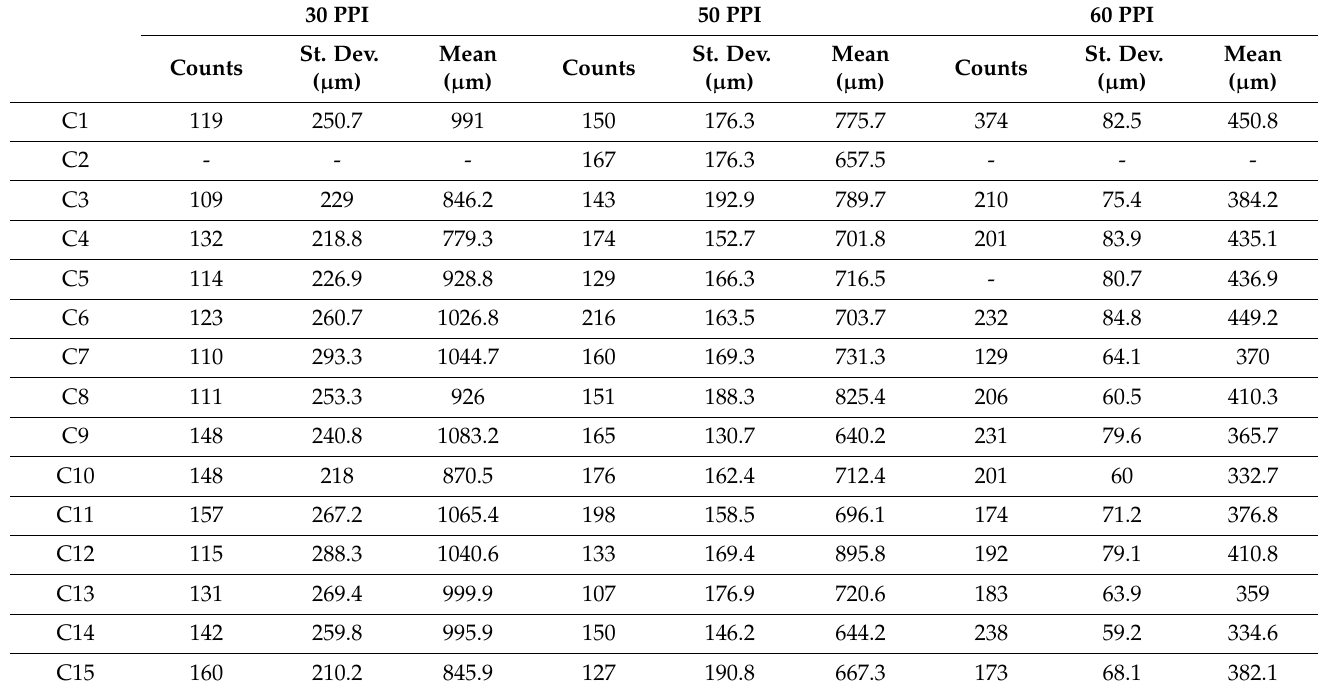
Table A8. Mean Window’s Feret diameter ( d w ) of CFF samples of 30 PPI, 50 PPI and 60 PPI from